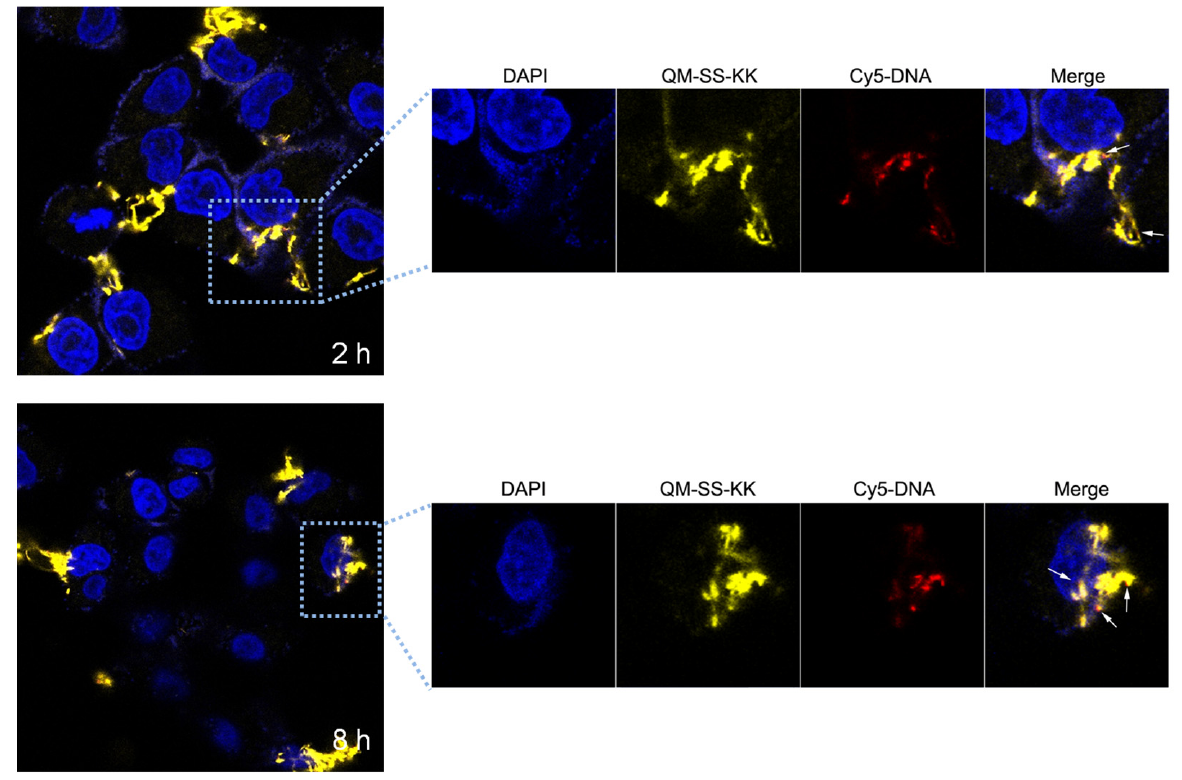
Figure 8. CLSM images of HeLa cells after the transfection with Cy5-labeled DNA by QM-SS- KK/DOPE at N/P ratio of 6 for different lengths of time (red: Cy5-labeled pDNA; yellow: QM-SS- KK/DOPE; blue: DAPI-stained cell nuclei).